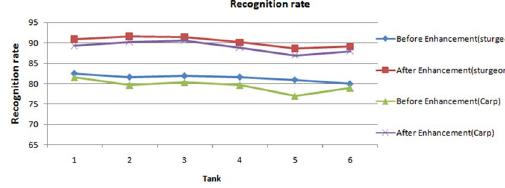
Figure 9. Recognition rates of carp and